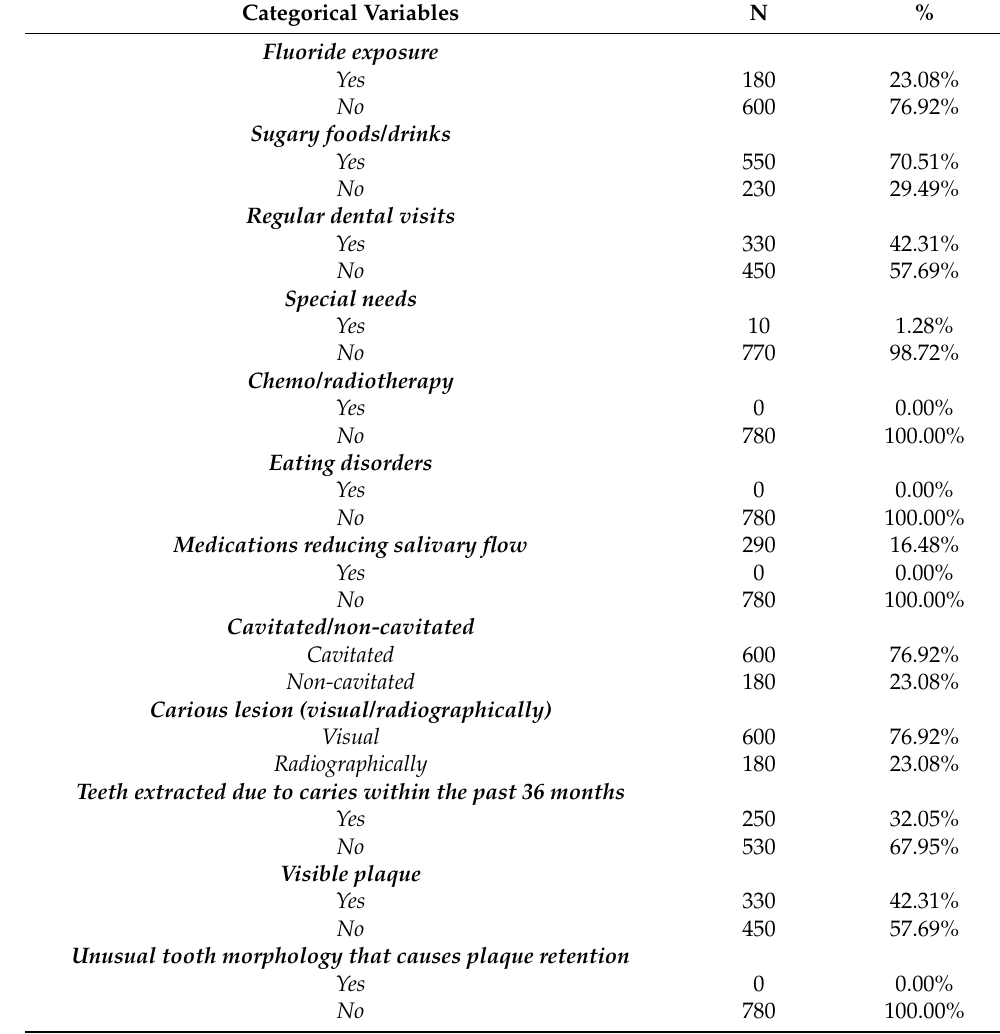
Table 1. Demographic characteristics (N =